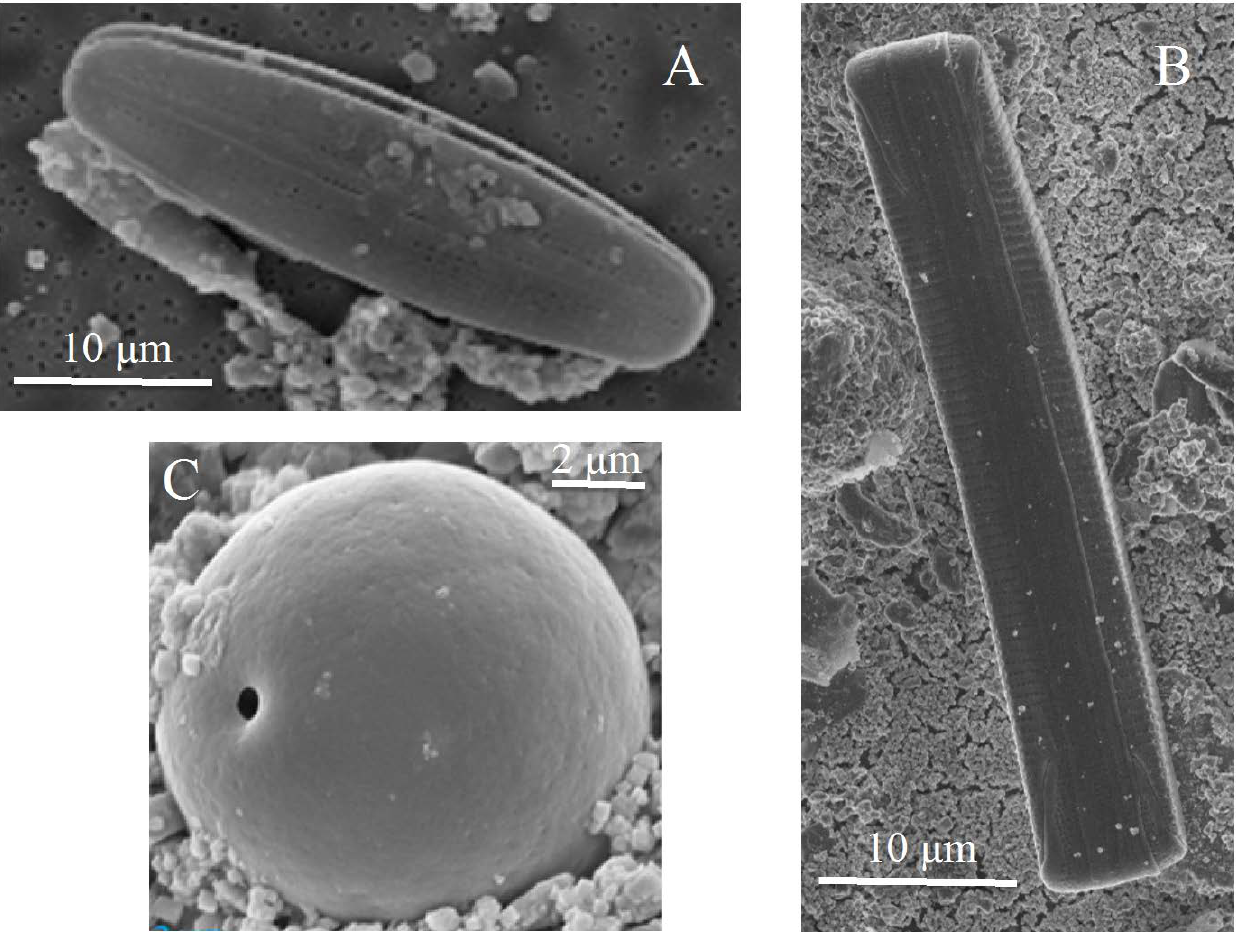
Figure A4. Scanning electron micrographs of two pennate diatoms ( A, B ) observed in the samples from Sverdrup as well as an eukaryote with physical similarities to Chrysophyceaen stomatocysts ( C